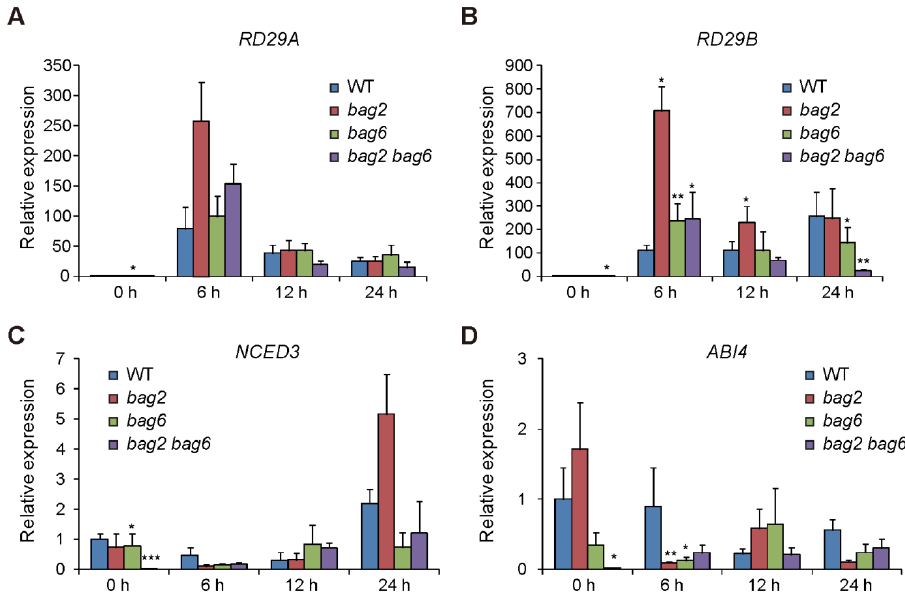
Figure 9. The relative expression of stress- and ABA-related genes. Transcription levels of RD29A ( A ) , RD29B ( B ), NCED3 ( C ), and ABI4 ( D ) genes in WT and bag2 , bag6 , and bag2 bag6 mutants were examined under ABA treatment for 0, 6, 12, and 24 h. Values are means ± SD of three replicates. * represent the significant differences at p < 0.05; ** represent p < 0.01; *** represent p < 0.001 (Student’s t -test).